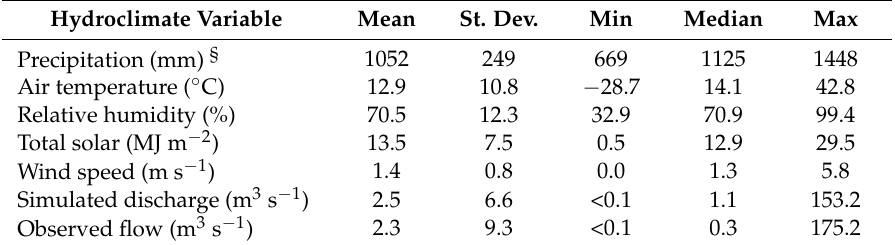
Table 3. Descriptive daily statistics showing reference (Soil and Water Assessment Tool (SWAT) simulated) and developed (observed) hydroclimate. Statistics shown represent hydroclimate at a U.S. Geological Survey gauging site (Site #4) in Hinkson Creek, MO,